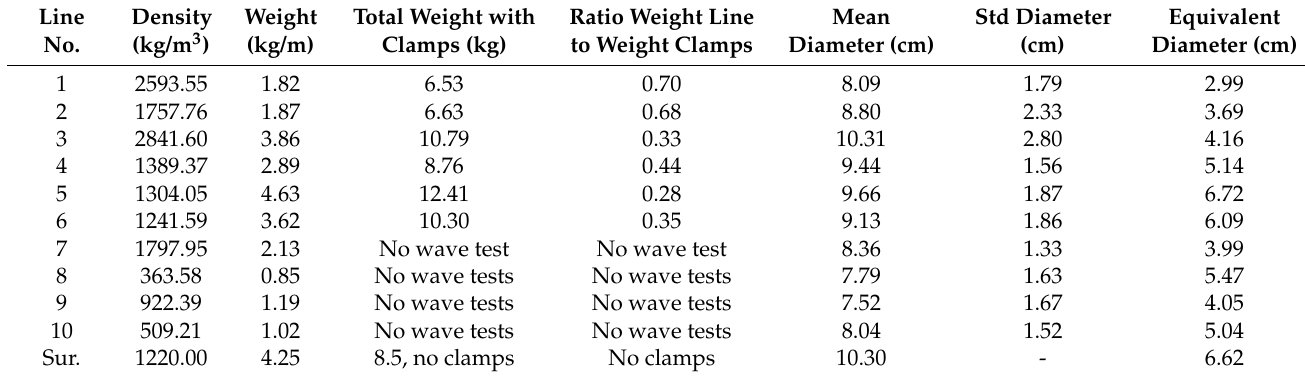
Table 3. Results of the dropper line testing.